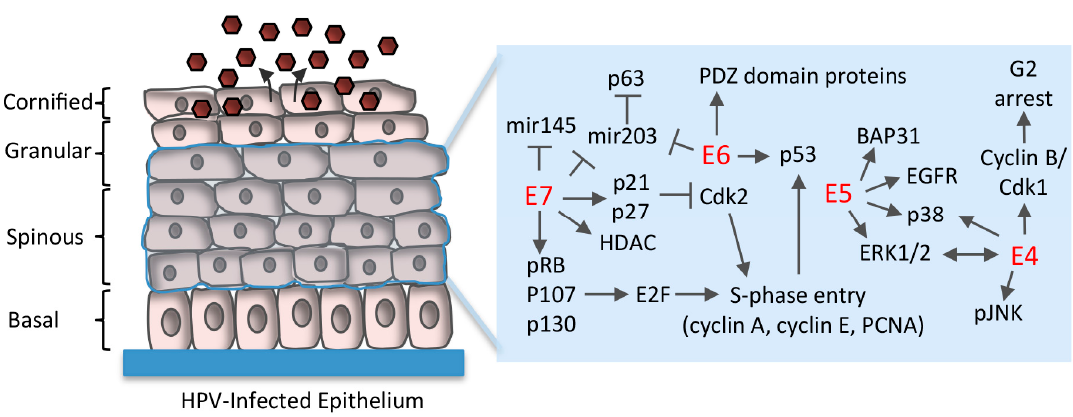
Figure 3. Cellular factors targeted by HPV proteins to maintain cell cycle competency in suprabasal cells. E7 pushes differentiating cells back into the cell cycle by binding to pRb, p107 and p130, which regulate entry into S-phase by negatively regulating E2F transcription factors. Disruption of the pRb/E2F interaction by E7 allows for constitutive activation of E2F-responsive genes, allowing for S-phase re-entry by post-mitotic cells. Unscheduled S-phase entry induced by E7 results in increased p53 that is targeted for degradation by E6 to avoid apoptosis or cell cycle arrest in G1, as well as to block p53’s negative effects on productive replication. E5 contributes to productive viral replication by maintaining cell cycle competency upon differentiation through interaction with BAP31, as well as through activation of epidermal growth factor receptor (EGFR), mitogen activated protein kinase (p38MAPK) and extracellular signal-regulated kinase (ERK)1/2. E4 may increase the efficiency of viral genome amplification by sustaining a G2-arrested environment upon differentiation, and through activation of MAPK signaling (p38, ERK1/2, pJNK). T bars indicate inhibition. Arrows indicate activation. HDAC: histone deacetylase; PCNA: proliferating cell nuclear antigen.